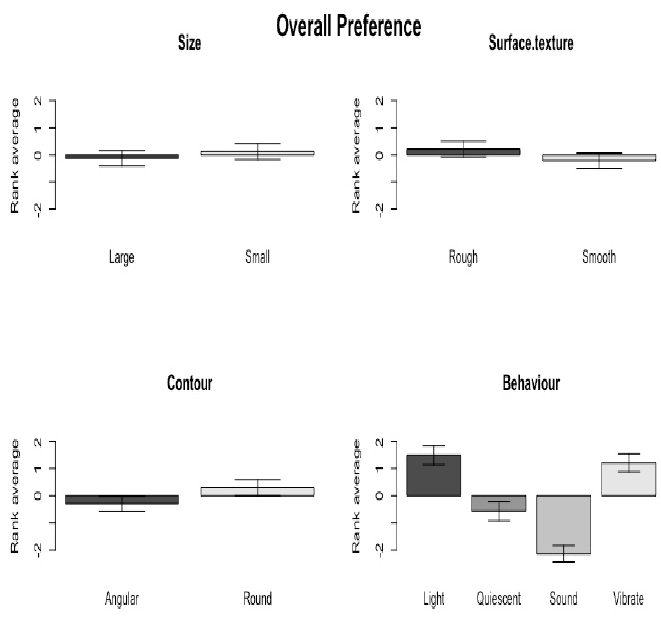
Figure 5. The overall preference of each variable.